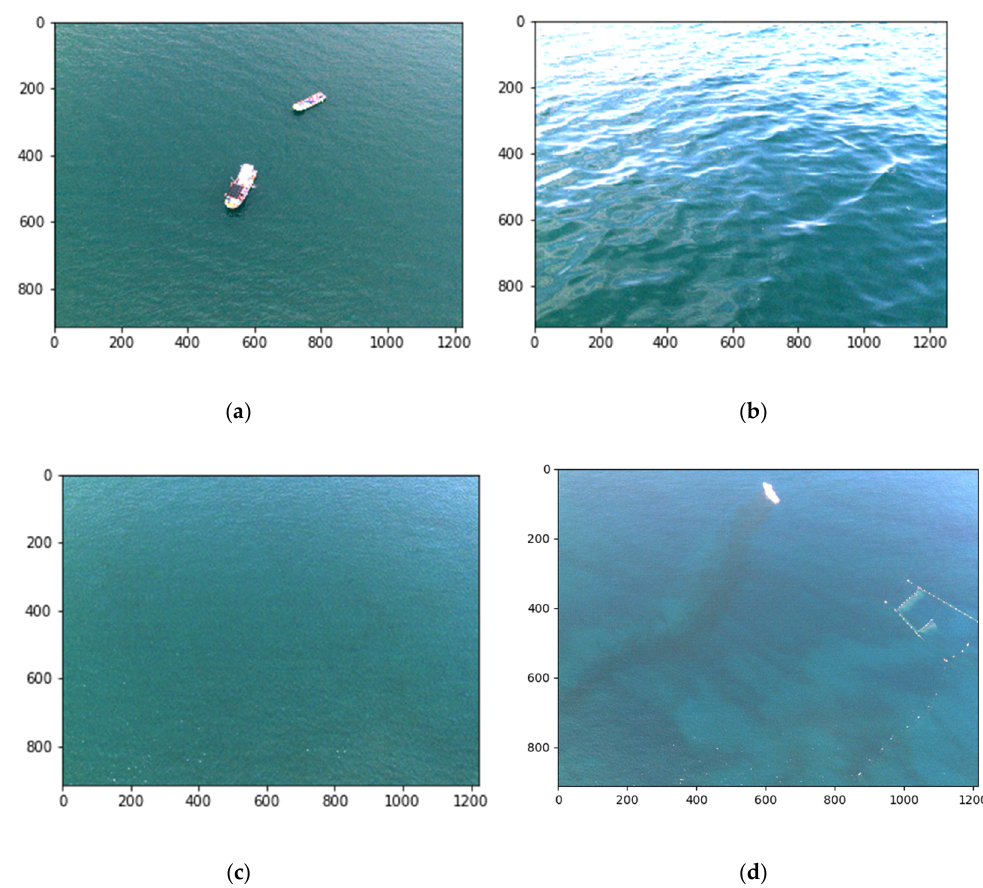
Figure 4. Water reflectance image (RGB: Band 3, Band 2, Band 1) acquired by the Rededge-M for ( a ) Scene-A (85.4 m), ( b ) Scene-B (8.1 m), ( c ) Scene-C (196.2 m), and ( d ) Scene-D (390.5 m, red tide), with the UAV altitudes in the parenthesis.